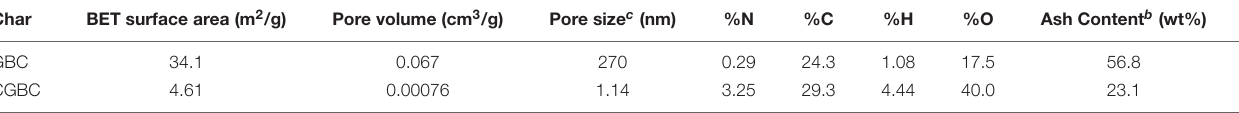
TABLE 1 | Properties of the studied biochars. a